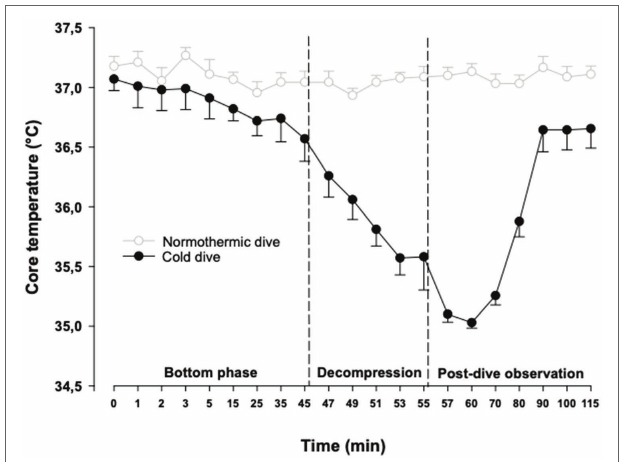
FIGURE 1 | Body core temperature. The cold dive group was normothermic during the bottom phase, cooled to 35 ° C during the decompression and rewarmed to 37 ° C after the dive. Temperatures are mean ± SEM. N = 9 in both groups. Data for the normothermic control dive group are adapted from Gaustad et al.